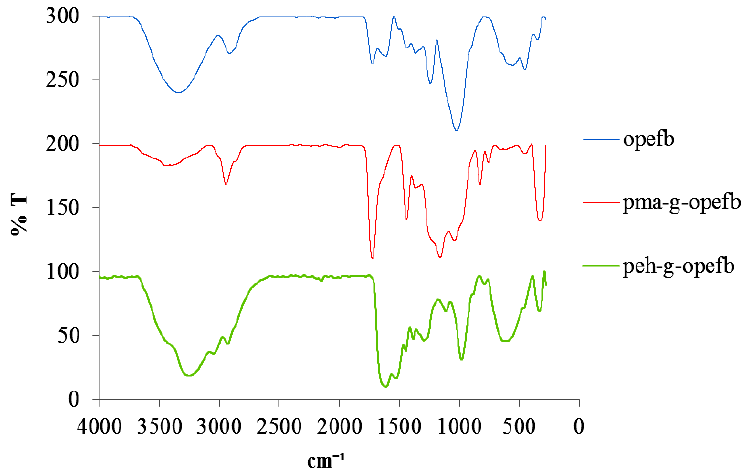
Figure 2. FTIR spectra of opefb, pma-g-opefb and